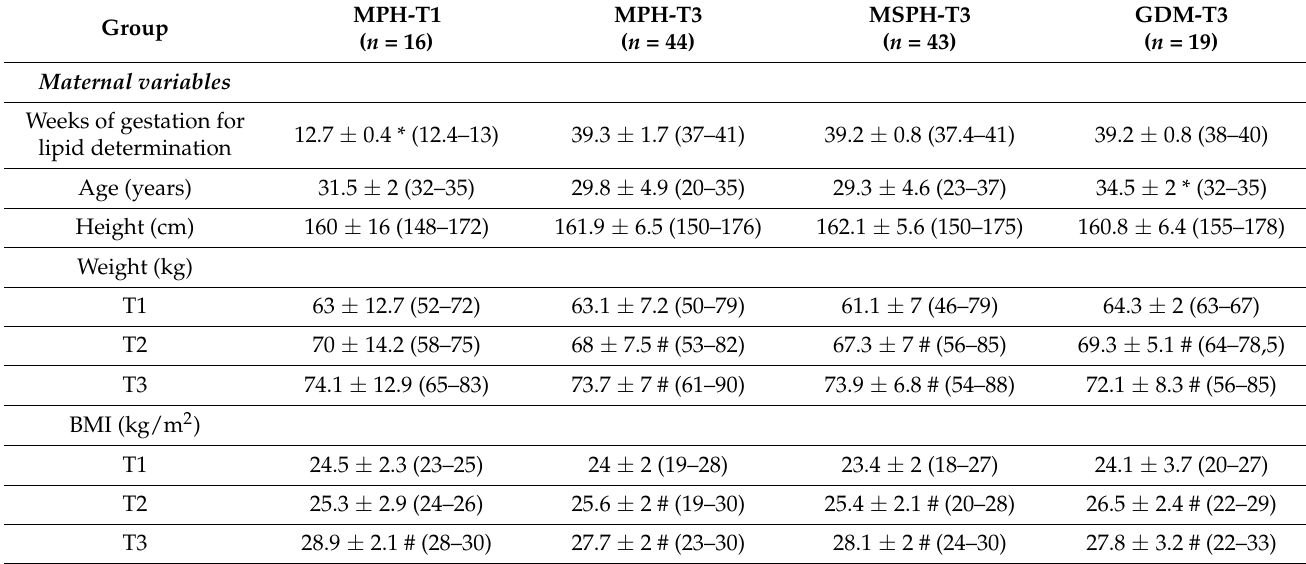
Table 1. Clinical characteristics of pregnant women and their